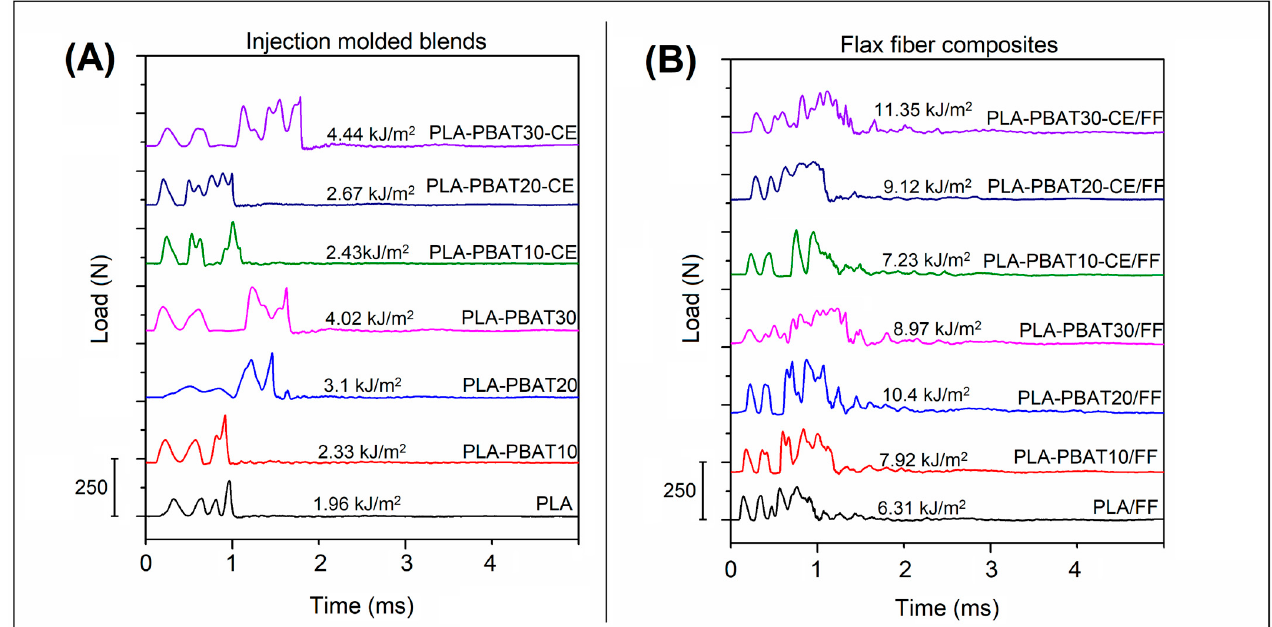
Figure 6. The load/time curves for the ( A ) injection molded samples, and ( B ) flax fiber reinforced laminates.